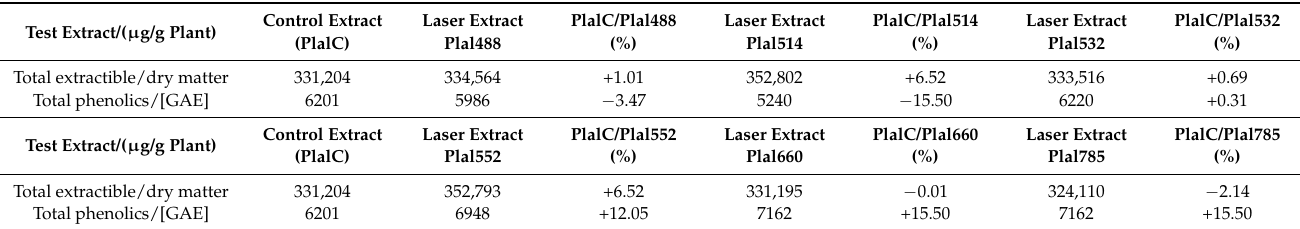
Table 1. Total extractible compounds and total phenolic compounds ( µ g/g plant, d.w., n = 3, mean value) in the aqueous extracts, non-irradiated extracts (PlalC) versus irradiated extracts